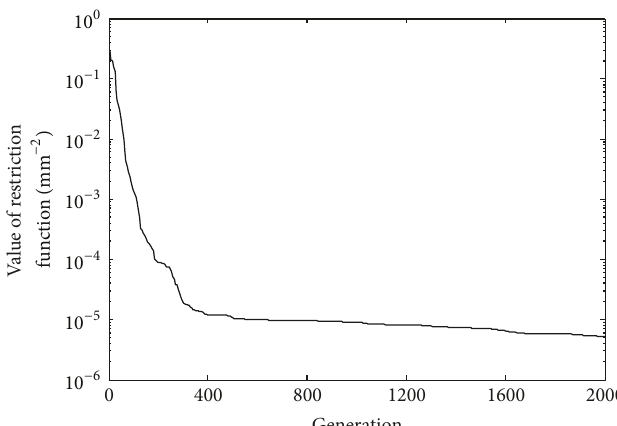
Figure 11: Variation of restriction function value.